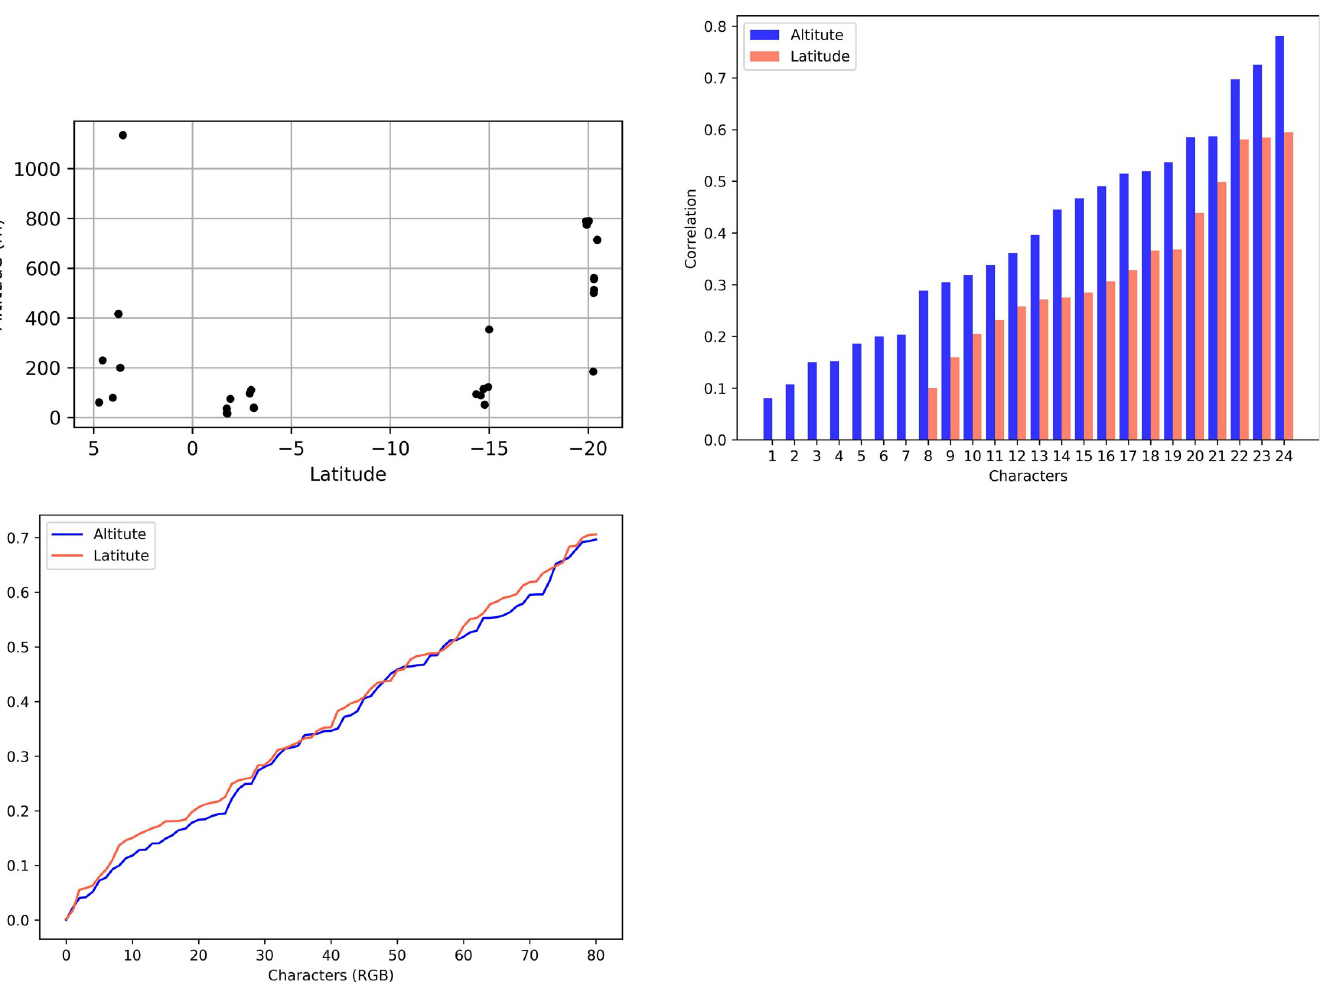
Fig 5. Relationship between altitude and latitude, and their correlation with all discrete and continuous characters investigated for female specimens of C . metamorphus sp. nov. (A) Latitude vs. Altitude data for all available females. (B) Sorted absolute values of point-biserial and polyserial correlation for altitude (blue, 1 st series), and of Crame´r’s V index for latitude (red, 2 nd series) for 24 categorical morphological characters (those of Table 3, but freely sorted here). The difference between the average correlation values of each series is 0.149367. (C) Absolute values of Pearson correlation for altitude (blue, bottom curve) and polyserial correlation for latitude (red, on top) vs. 81 RGB (color) characters. The difference between the average correlation values of each series is only 0.014824 in favor of latitude. Characters on charts B and C were independently sorted for the altitude and the latitude series, to highlight the net differences in correlation.